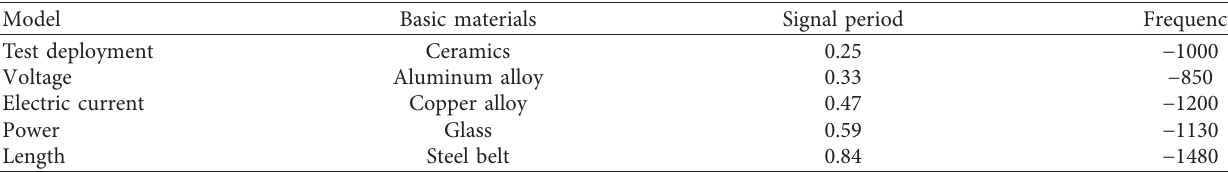
Table 1: CPLD chip working parameters.